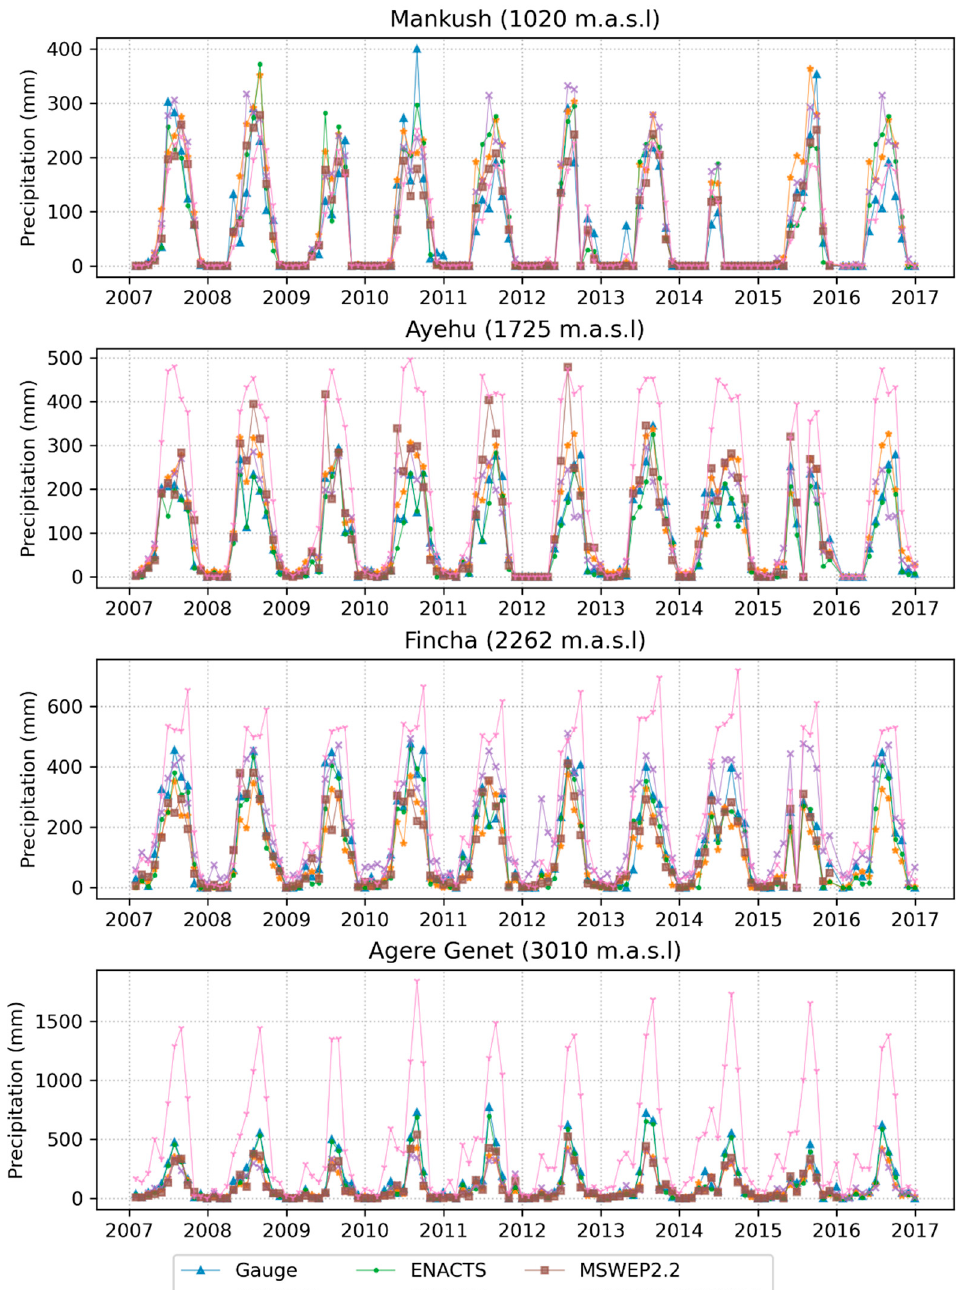
Figure 10. Monthly scale comparison of the precipitation datasets at selected gauge stations over the UBNRB.